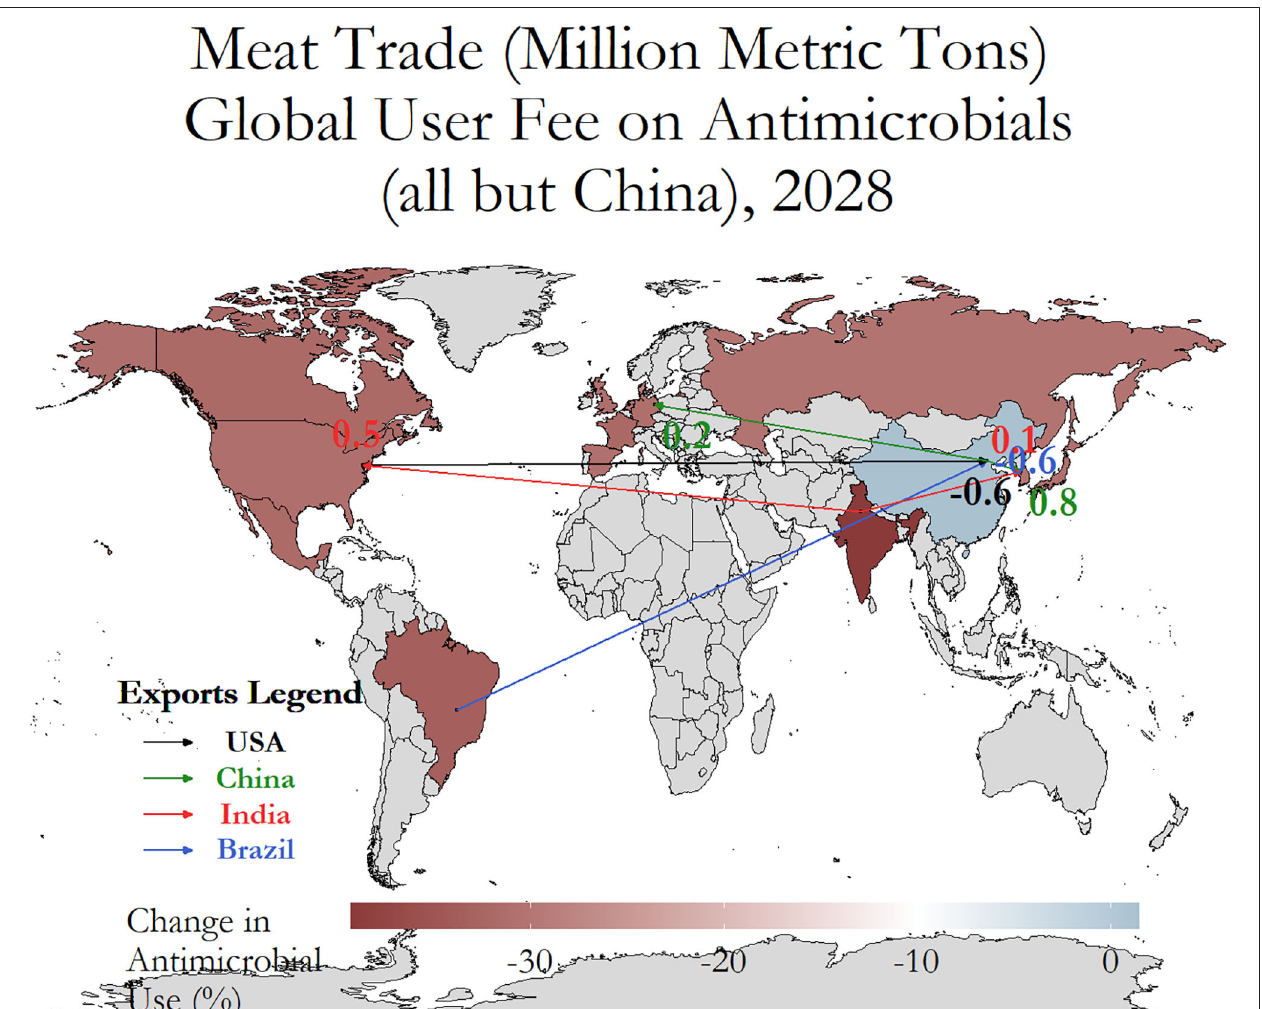
FIGURE 3 | Change in meat exports in million metric tons (MMT). Increased antimicrobial user fees reduce antimicrobial use in livestock production world-wide by 12%. When China does not adopt the policy, it gains a competitive advantage in the global market and its meat exports